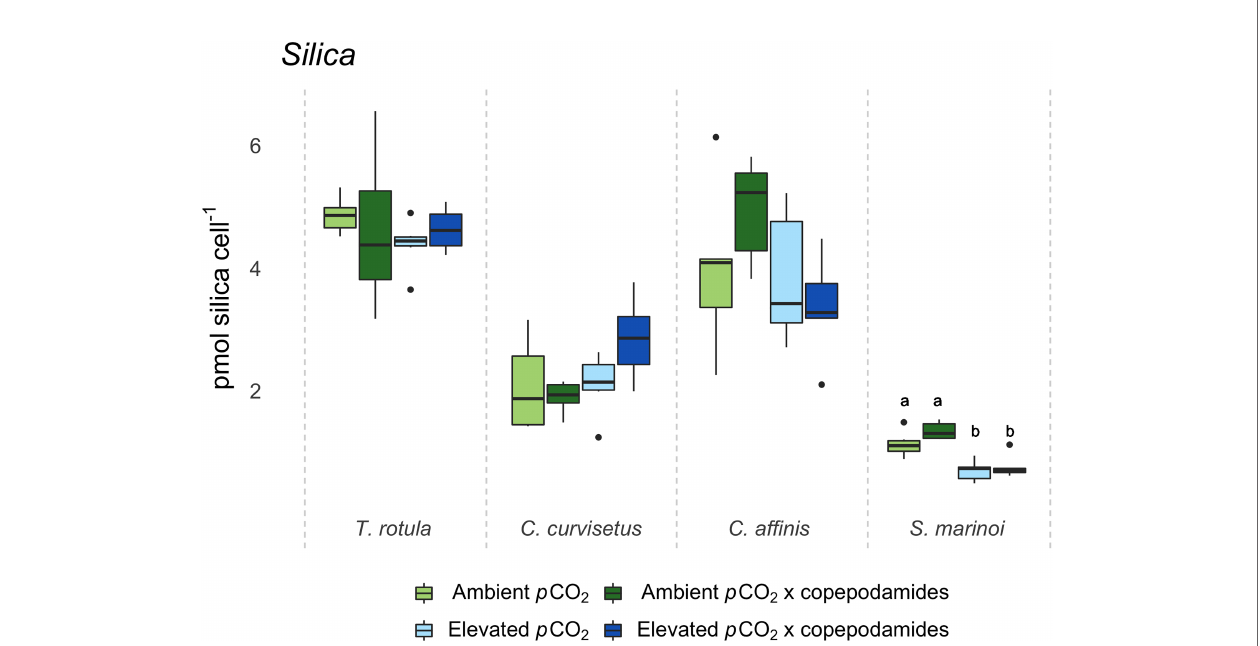
FIGURE 3 | Box plot of silica content (pmol silica cell -1 ) for Thalassiosira rotula, Chaetoceros curvisetus, Chaetoceros af fi nis and Skeletonema marinoi after 48 hours exposure to one of four treatments ( “ ambient p CO 2 ” , “ ambient p CO 2 x copepodamide ” , “ elevated p CO 2 ” or “ elevated p CO 2 x copepodamide ” ). Solid line inside the box signi fi es the median, box contains the lower and upper quartile ranges; letters denote signi fi cance ( p < 0.05), n = 6, for all groups but C. af fi nis “ ambient p CO 2 ” and S. marinoi “ elevated p CO 2 ” where n = 5.